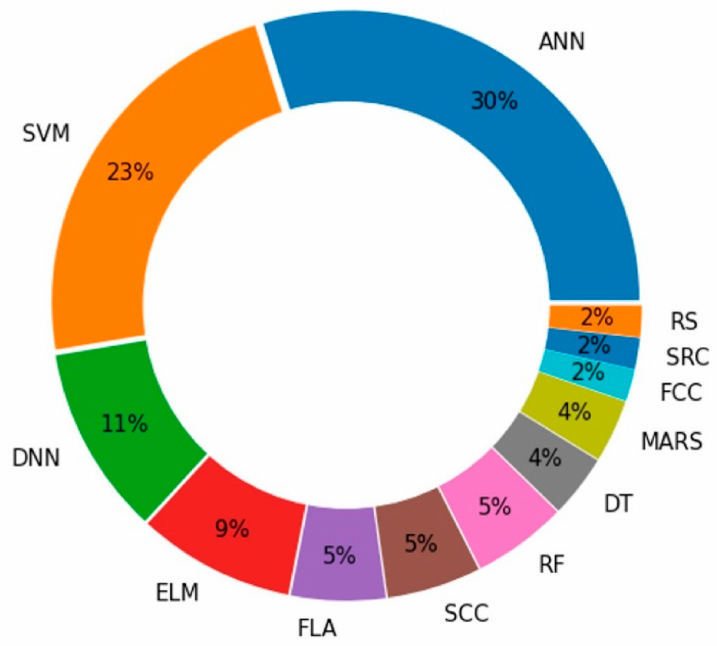
Figure 10. Breakdown of the classification